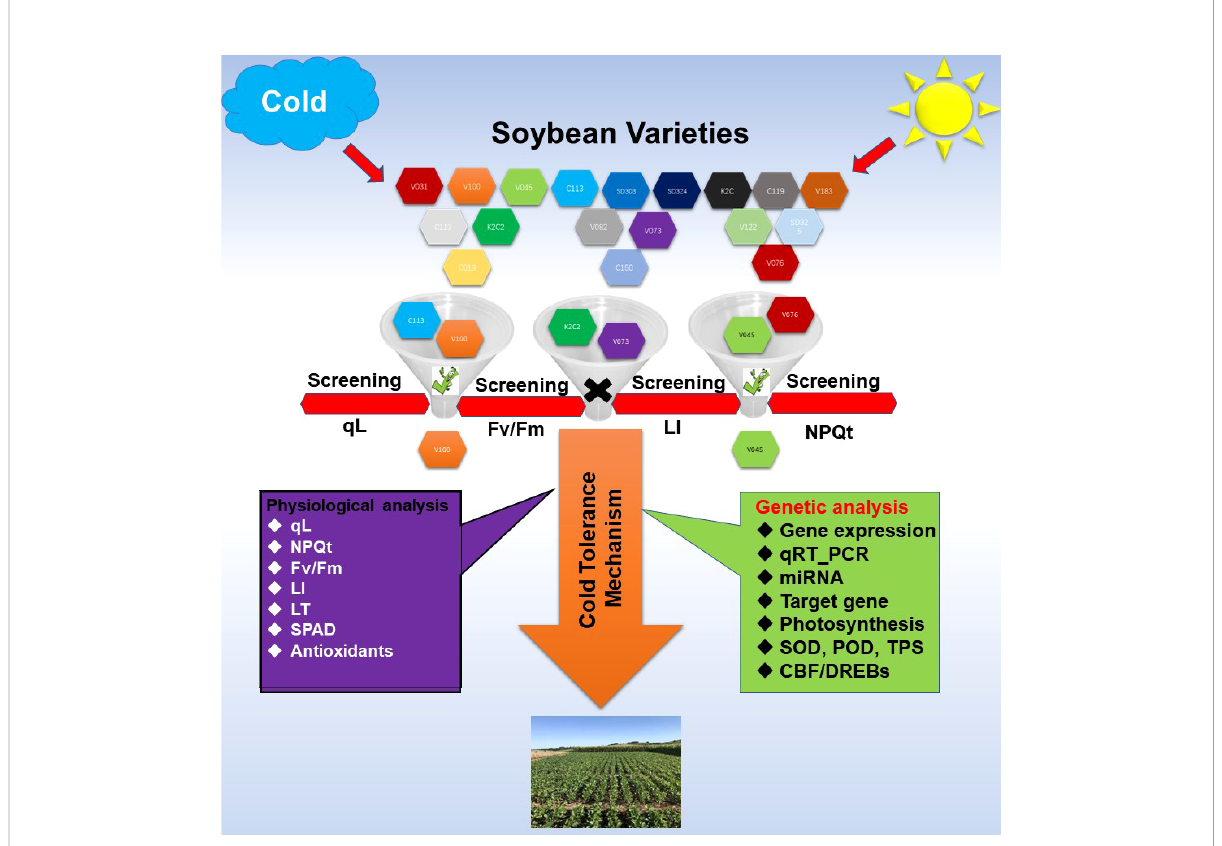
FIGURE 11 Methodology adopted to identify the cold tolerant germplasm in Soybean. Soybean varieties were screened under control and cold stress conditions to identify the cold tolerant germplasm based on physiological and phenological traits. Physiological traits such as qL, Fv/Fm, NPQT (non ‐ photochemical quenching), SPAD value, antioxidants enzymes activity such as SOD, POD, and H 2 O 2 and MDA level were measured. Phenological leaf injury (LI) and leaf thickness were recorded and analyzed. For genetic analysis, the expression levels of cold stress related genes and cold marker genes were analyzed through RNA-seq and qRT-PCR analysis. The posttranscriptional regulators of these genes were excavated. All these analysis combinedly help to explain the major difference for cold tolerance and cold sensitivity in soybean